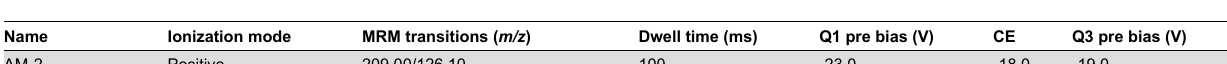
Table 4. The MRM parameters for